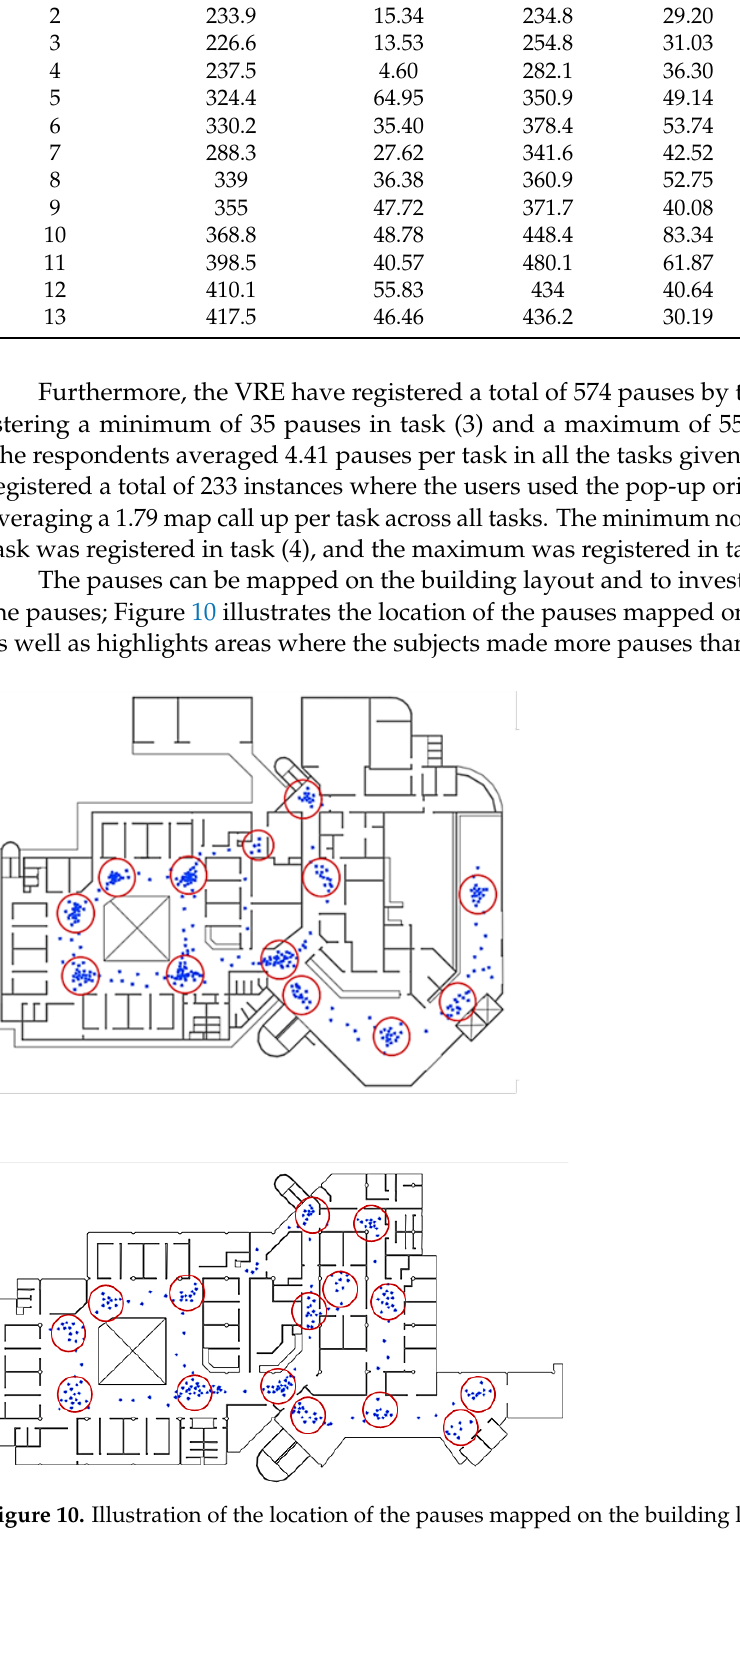
Table 2. Summary of the data recorded from the Ruka 1st VRE. Average Distance Task No. (Meter)